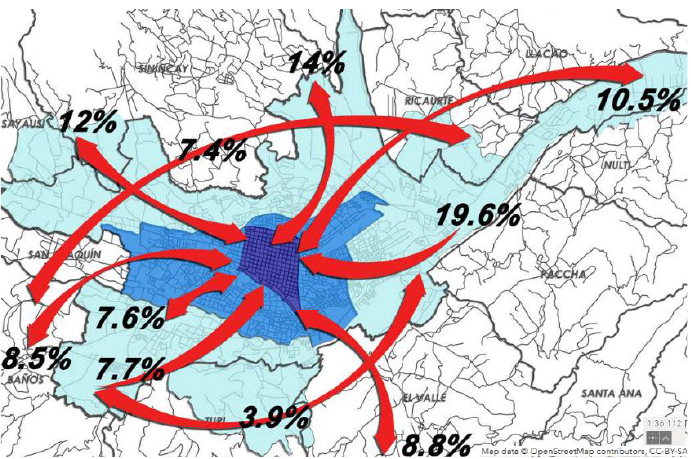
Figure 2. Relation of the location of the destination in vehicular mobility .